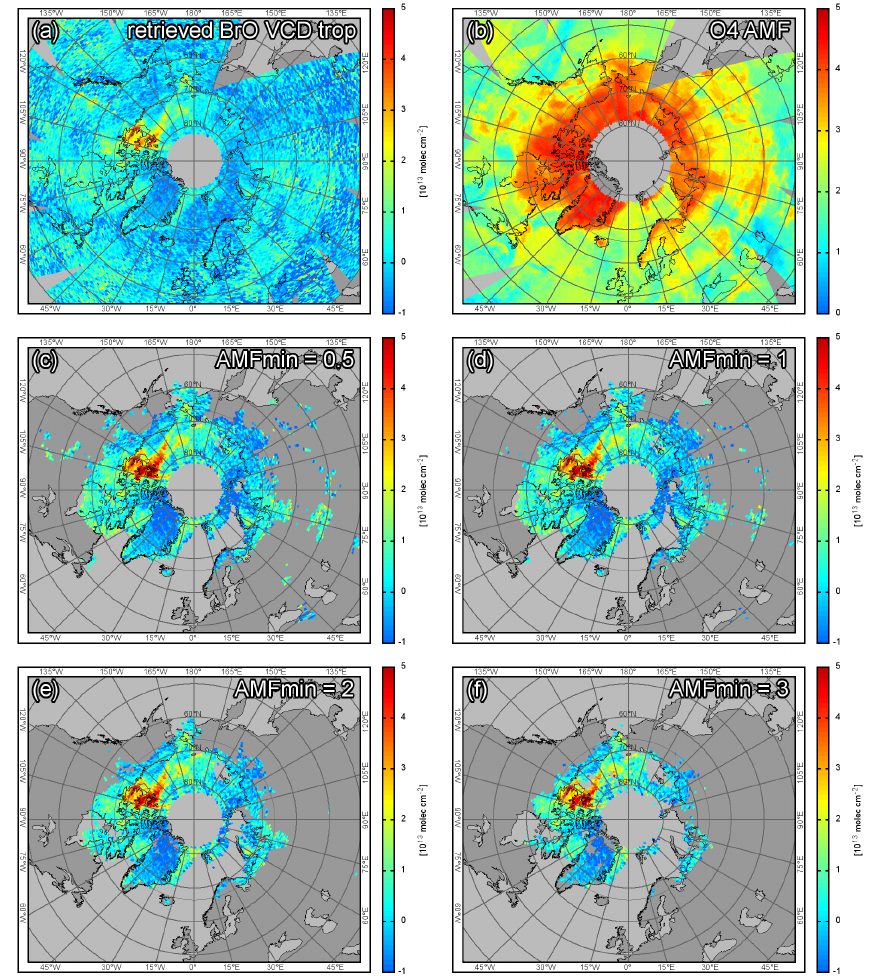
Fig. 6. Illustration of the sensitivity filter and tropospheric AMF applied on GOME-2 measurements for 25 March 2009 (same as Fig. 1). (a) The retrieved tropospheric BrO VCDs are filtered according to the respective minimum sensitivity to trace gas concentrations close to the surface using (b) measured AMFs of O 4 . Panels (c) through (f) show tropospheric BrO VCDs for different sensitivity thresholds = 0 . 5, 1, 2, 3, respectively. Note that the sensitivity to the choice of AMF min AMF min 500 calculated using A 500 . Areas without any sensitive measurements are left